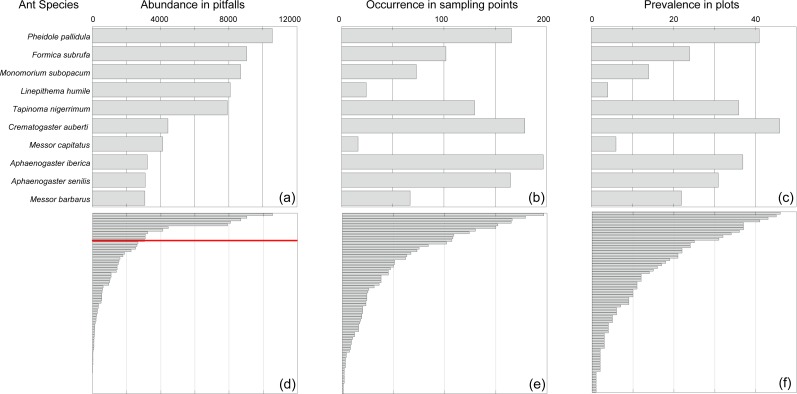
Abundance in pitfalls (A), occurrence in sampling points (B) and prevalence across plots (C) of the tenth more abundant species (above the red line in D) and of the remaining species (D–F).